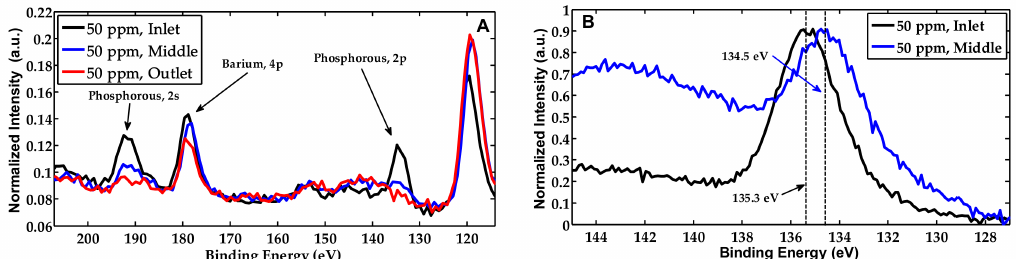
Figure 6. ( A ) Normalized X-ray photoelectron spectroscopy (XPS) spectra from the inlet, middle and outlet section of the Pt/Ba/Al 2 O 3 sample exposed to 50 vol.-ppm H 3 PO 4 for 34 h. ( B ) Corresponding XPS spectra for the P 2p region from the inlet and middle section of the sample.